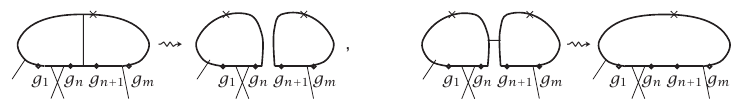
Figure 7.7 . A recursive description of W ob